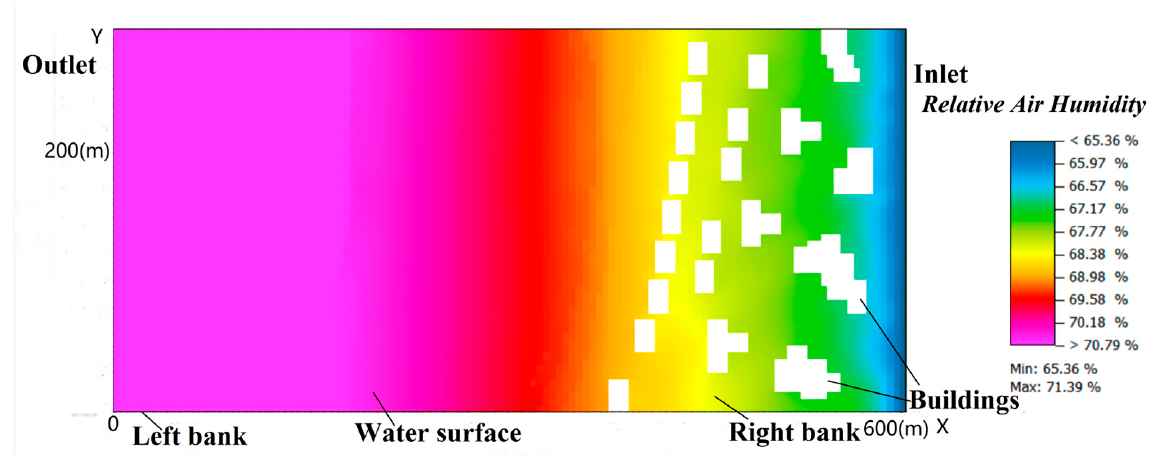
Figure 7. The variation of relative air humidity over time. The distribution of relative air humidity at 16:00 is shown in Figure 8. It can be seen that within 0–10 m of the riverbank, the relative air humidity is 69.68% on the right bank and 70.23% on the left bank. Within 10–30 m of the riverbank, the relative air humidity on the right bank is 69.32% and that on the left bank is 70.16%. Within 30–50 m of the riverbank, the relative air humidity on the right bank is 68.54% and that on the left bank is 69.95%. It can be concluded that the relative air humidity is lower further away from the riverbank. Note that the relative air humidity of the left bank is higher than that of the right bank. The main reason for this phenomenon is attributed to the air on the left bank absorbing water vapor from the surface of the river when passing across the river. The water in the river is continuously transported downwind, leading to an increase in relative air humidity. The data in Figure 8 indicate that the relative air humidity increases by 0.38% after the air flows through the woods, decreases by 0.1% after the air flows across the road, and increases by 1.7% after the air flows across the river. Therefore, the order of influence of different underlying surfaces on relative air humidity is obtained as follows: rivers > trees > roads.